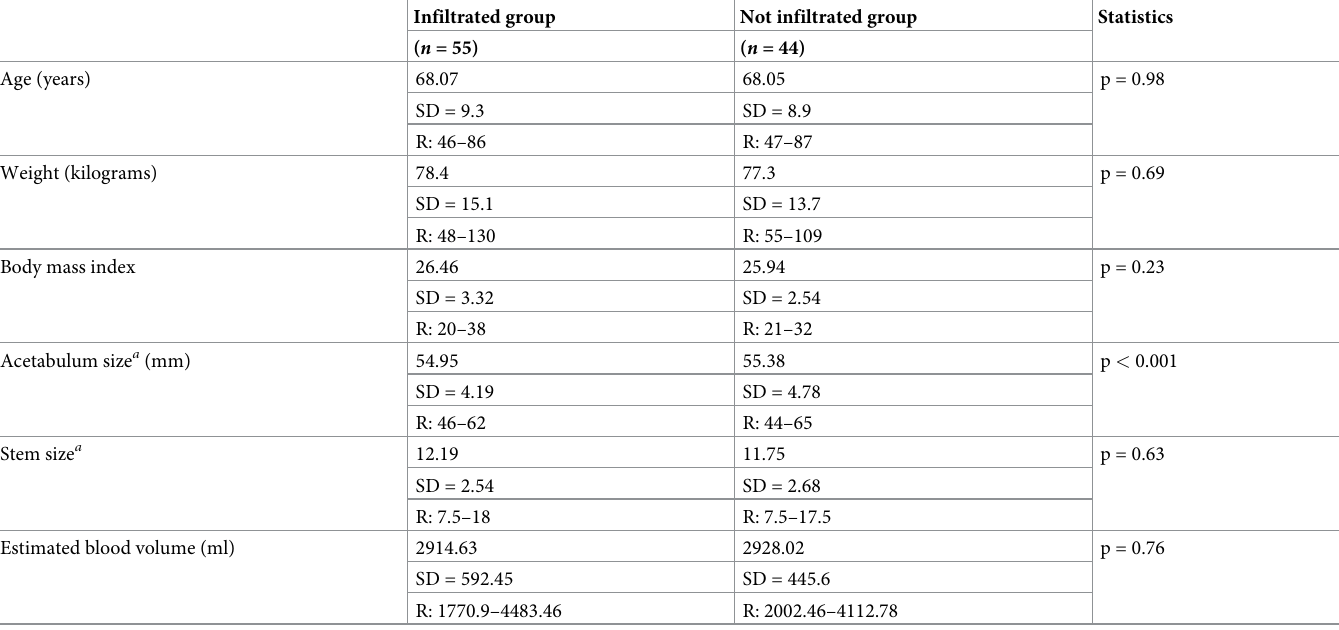
Table 1. Patient characteristics.